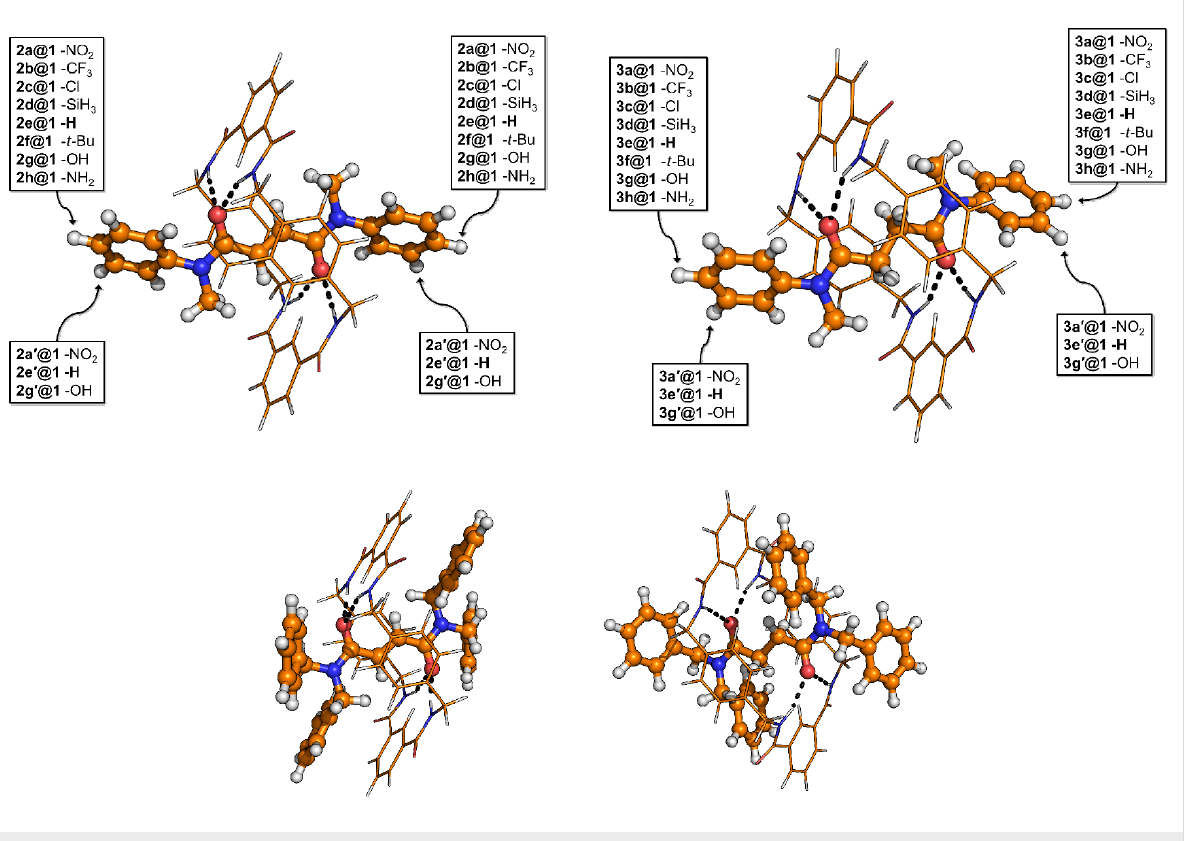
Figure 1: Chemical structure of the investigated systems. Left: Double bond within the axle; Right: Single bond within the axle. Red marks oxygen atoms, blue nitrogen atoms, orange carbon atom and hydrogen atoms are given in white. The labeling according to the substitution is given in bold letters. Structures below will be denoted 4@1 (left) and 5@1 (right).